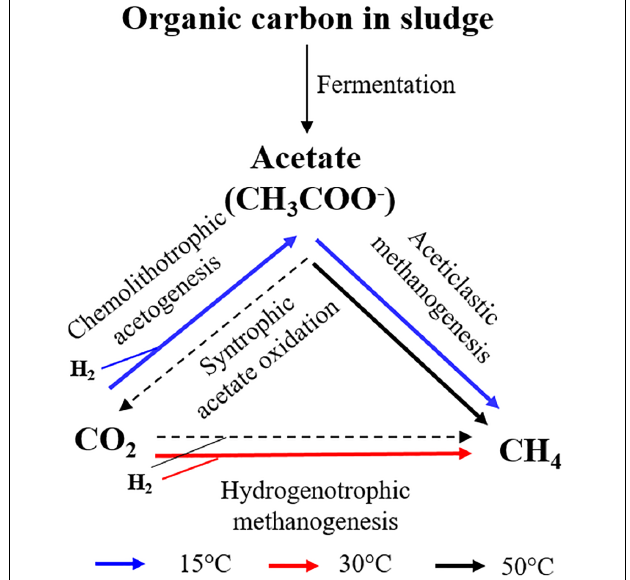
FIGURE 6 | The pathways for consumption of H 2 /CO 2 during the anaerobic digestion of sewage sludge at 15, 30, and 50 ◦ C.